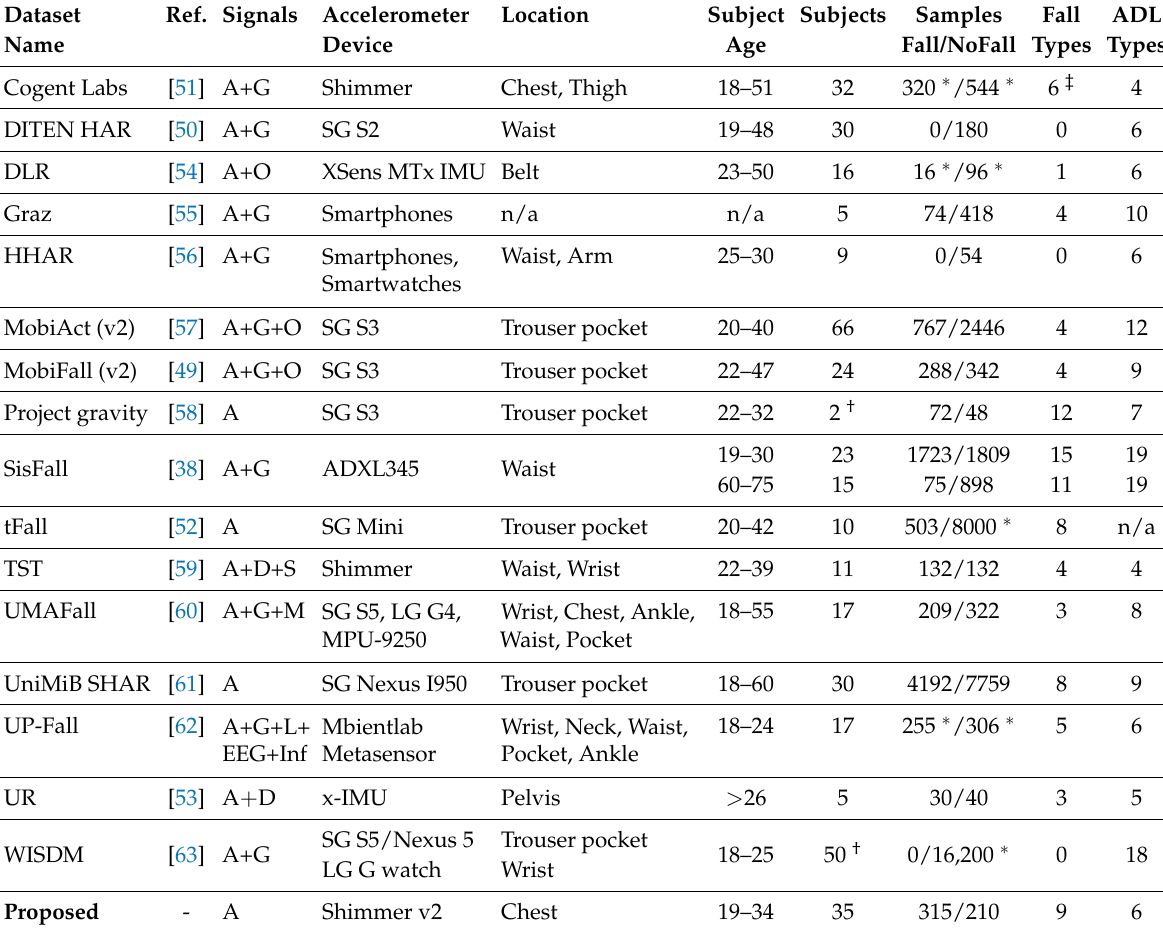
Table 6. Publicly available accelerometer-based fall and ADL detection